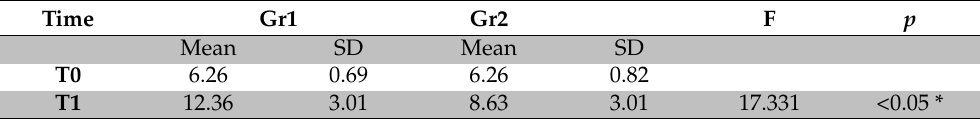
Table 7. Effect of time * group interaction on task 2